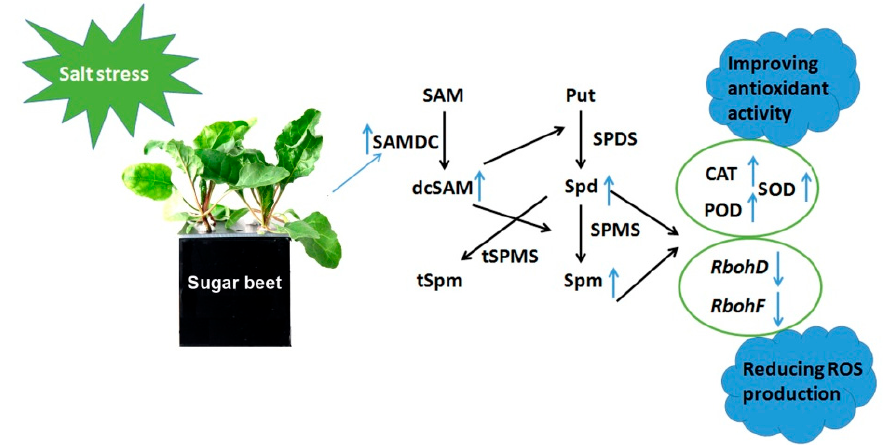
Figure 7. Overview diagram showing how the Bv M14-SAMDC functions in mediating plant salt stress tolerance. Salt stress can turn on the expression of BvM14-SAMDC, which plays an important role in the biosynthesis of PAs. PAs may inhibit the expression of ROS-biosynthetic enzymes and activate ROS-detoxifying enzymes, leading to reduced ROS levels and enhanced salt stress tolerance phenotype. SAMDC, S-adenosylmethionine decarboxylase; SPDS, spermidine synthase; SPMS, spermine synthase; tSPMS, thermospermine synthase; dcSAM, decarboxylated S-adenosylmethionine; Put, putrescine; SAM, S-adenosylmethionine; Spd, spermidine; Spm, spermine.